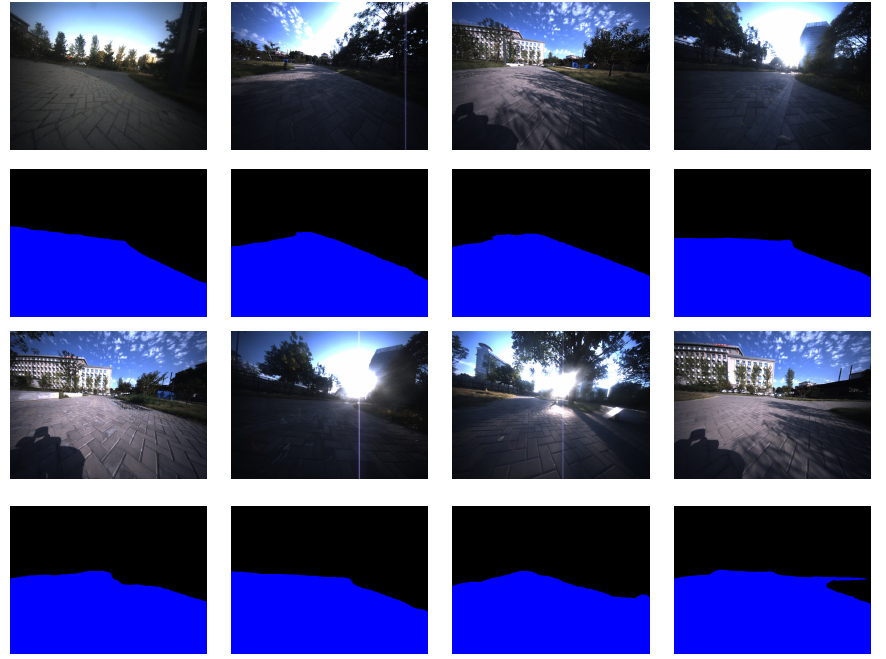
Figure 5. Semantic segmentation results of road edge information on the campus